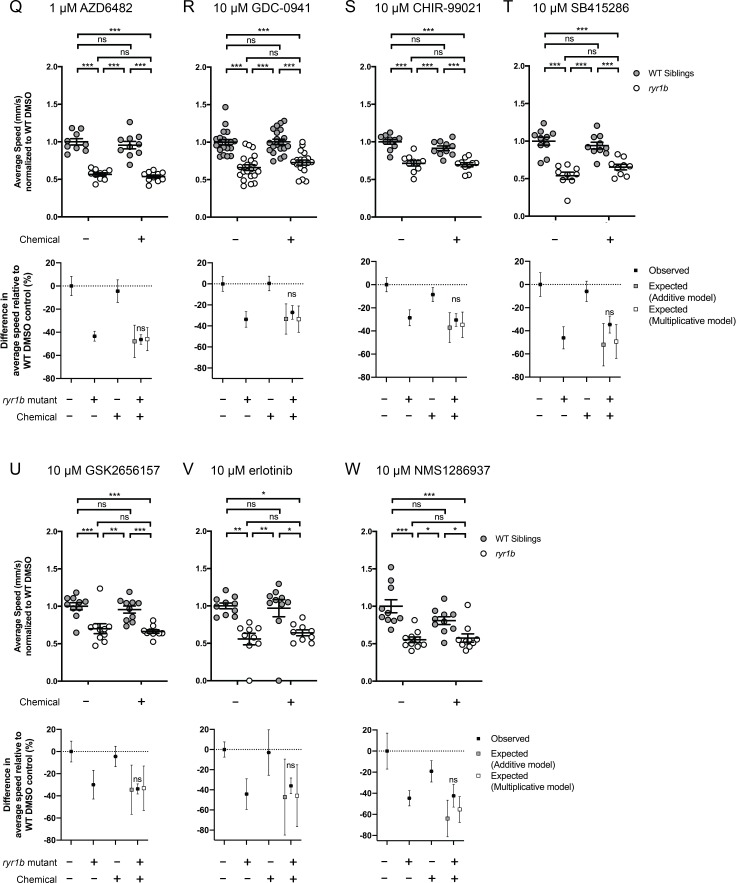
Chemical-genetic interactions were tested using zebrafish larval movement speed as a readout.Compared to the average speed of DMSO WT controls, chemical-genetic interactions were not observed for 18 hits from the C. elegans screen when tested in this assay (Figure 4—figure supplement 2–3F–W). Data are presented as mean ± SEM movement speed (mm/s) normalized to DMSO-treated WT siblings for n = 2 independent experiments for (A–E), (G), (H), (K), (L), and (R), where sample size n = 19 or 20 for each treatment group in a set and n = 1 experiment and sample size n = 9 or 10 for the remainder. Statistical analysis by two-way ANOVA followed by Tukey’s multiple comparisons post-test. *p<0.05, **p<0.01, ***p<0.001.